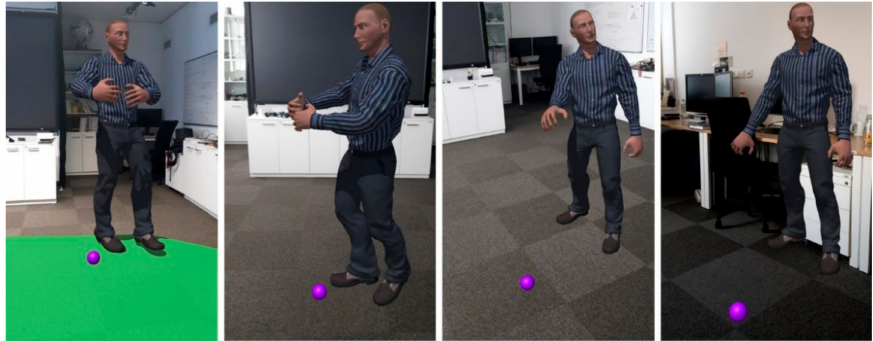
Figure 3. Dance animation examples of male avatar presented in augmented reality (AR)